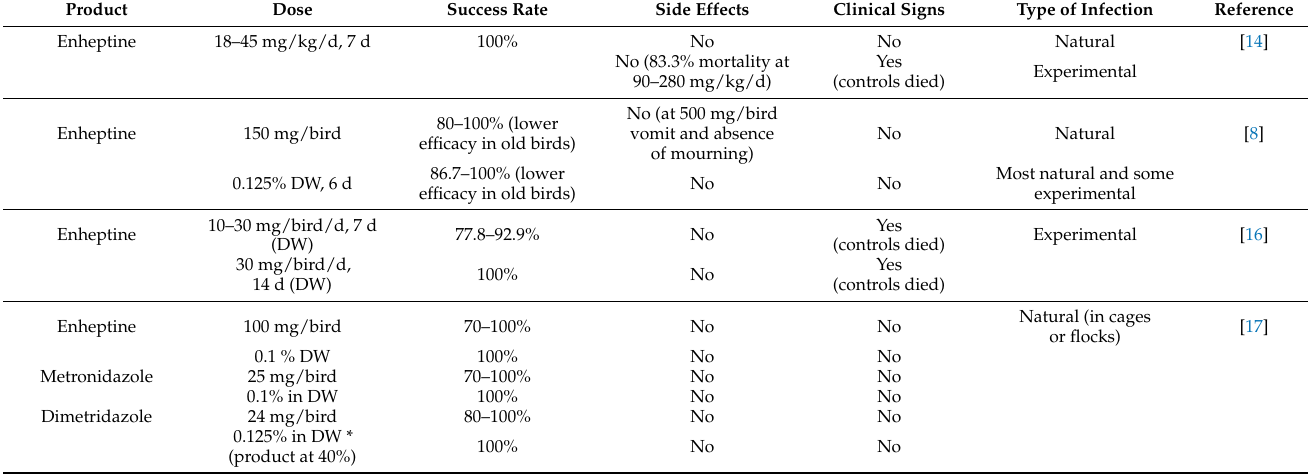
Table 1. Treatment employed against avian oropharyngeal trichomonosis in domestic pigeons ( Columba livia ). Products, doses and success rates are indicated, as well as side effects. Only effective drugs (efficacy higher than 80%) are included in the